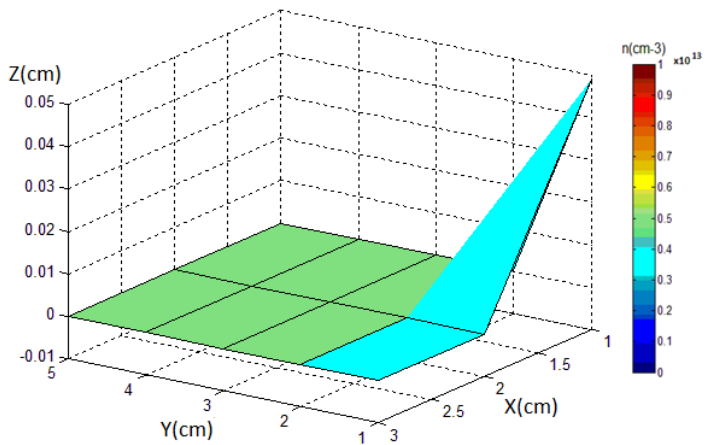
Figure 9: The spatial profile of electron number density of carbon laser induced plasma at z=7cm.